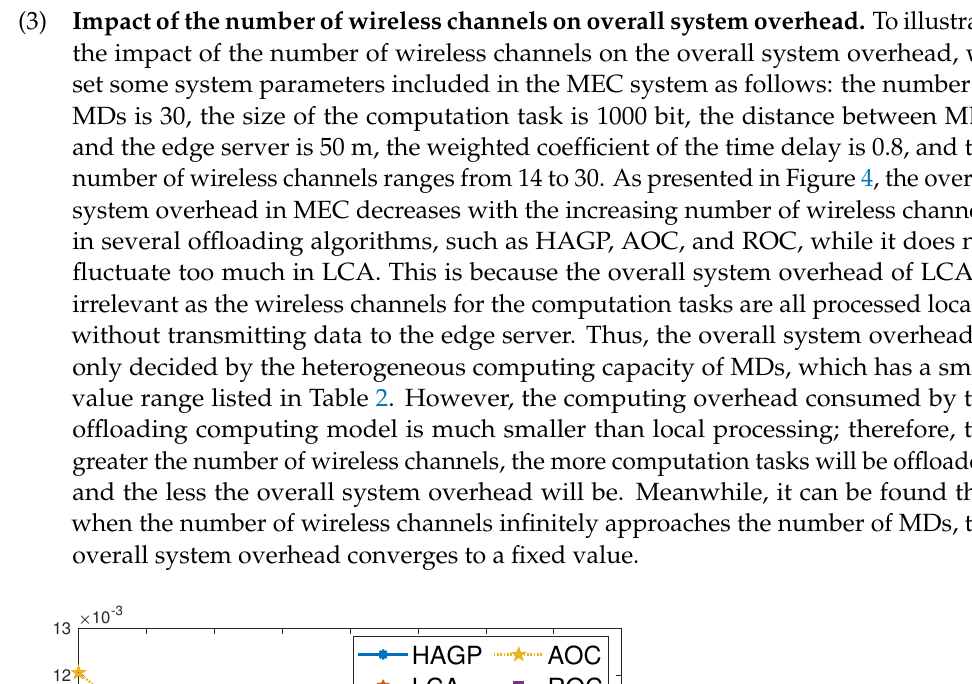
Figure 3. Overall system overhead vs. the number of MDs.